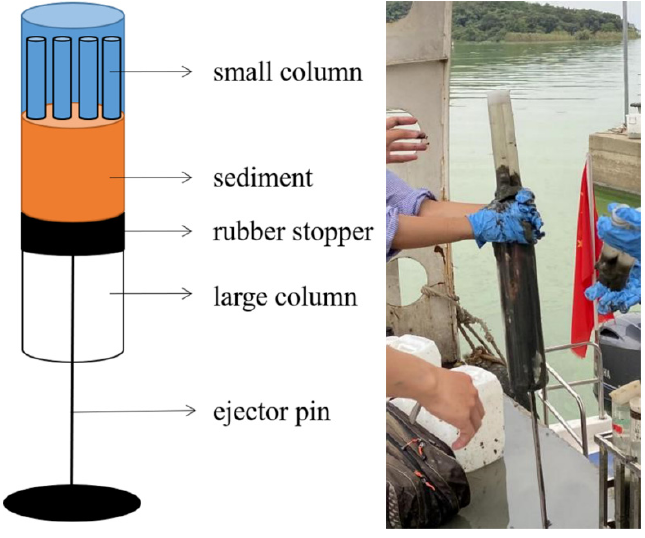
Figure 3. Schematic diagram of the sampling device.